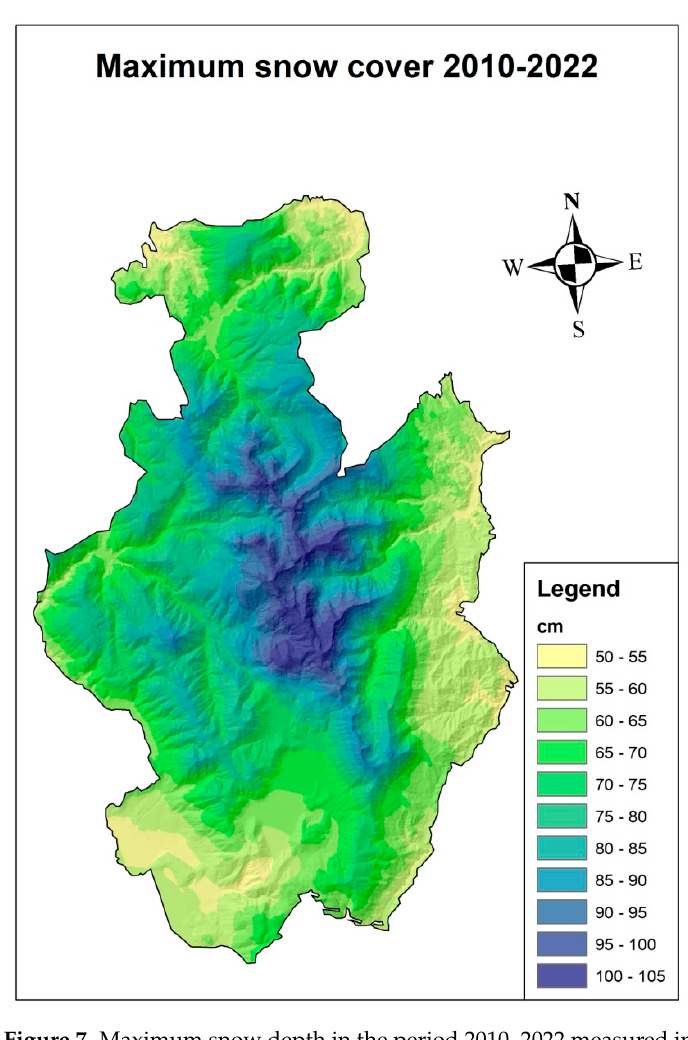
Figure 7. Maximum snow depth in the period 2010–2022 measured in cm.